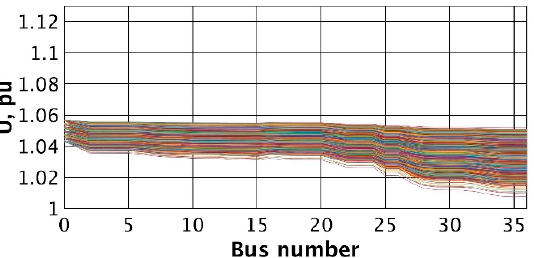
Figure 8. The results of the voltage analysis in the IEEE 37 network without the participation of sources. of